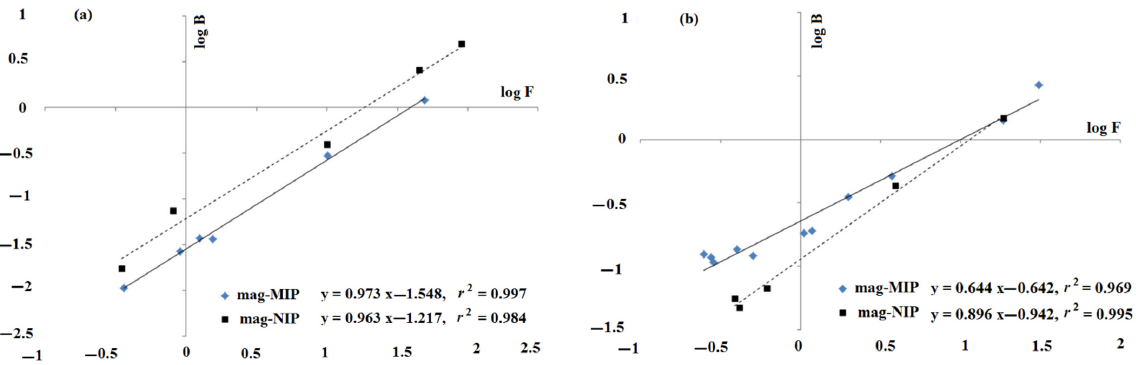
Figure 1. Freundlich isotherms for ANT ( a ) and ANT-OH ( b ) on mag-MIP and mag-NIP. The system that has more than one population of adsorption sites is characterized by more than one line. The Scatchard plot for ANT-OH on mag-MIP and mag-NIP is presented in Figure 2. The analysis revealed two straight lines for mag-MIP and only one line for mag-NIP. It means that two classes of adsorption sites for ANT-OH were predominant in mag-MIP with two K d and two B max values: K d (1) = 0.319 µ g L − 1 and B max (1) = 0.240 µ g g − 1 for the higher affinity adsorption sites, and K d (2) = 34.6 µ g L − 1 and B max (2) = 5.82 µ g g − 1 for the lower affinity adsorption sites. Thus, the mag-MIP possessed specific adsorption sites for ANT-OH. In contrast, the mag-NIP had only one low affinity adsorption site characterized by the value of K d = 33.8 µ g L − 1 and B max = 4.19 µ g g − 1